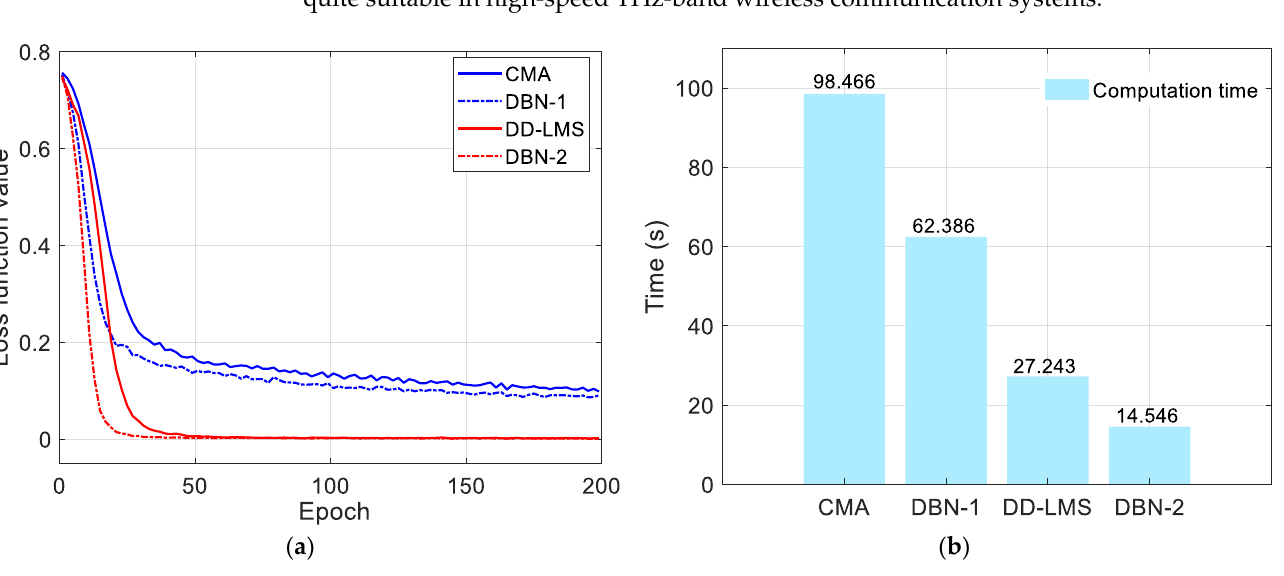
Figure 8. Complexity analysis of the 36 Gbaud QPSK signals with different equalization options when the input power into AIPM is 12.8 dBm. ( a ) Loss function versus iteration numbers. ( b ) Comparison of the computation time.